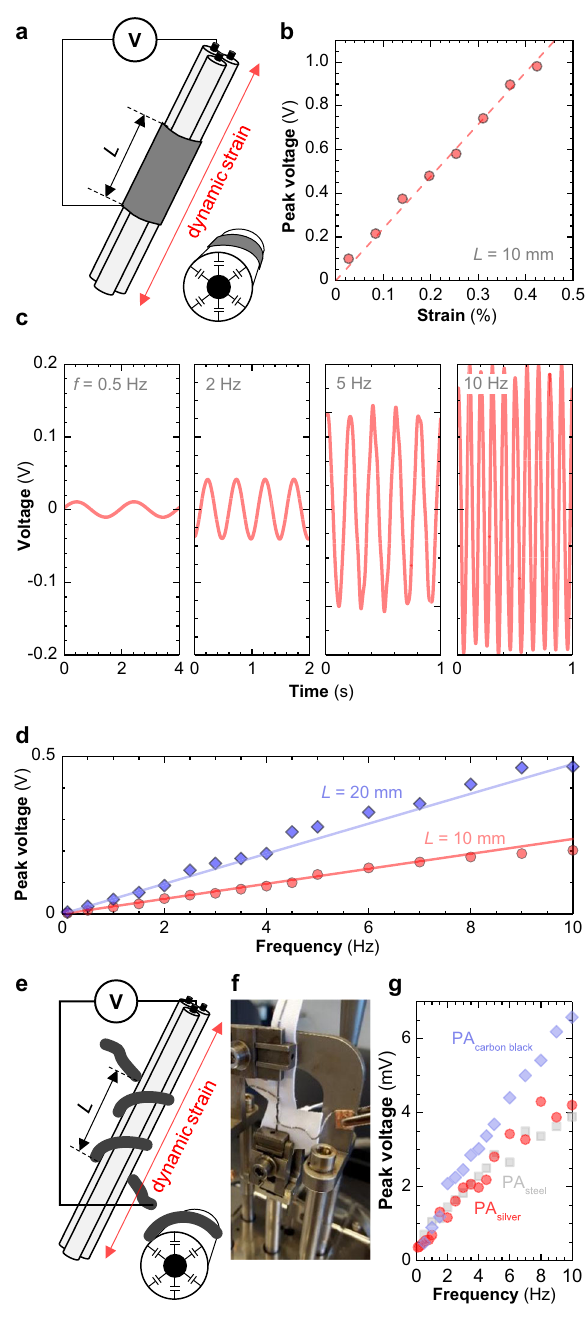
Fig. 2 Piezoelectric characterisation of single piezoyarns. a Sche- matic of a piezoyarn with silver paste applied over a length L . For clarity, only 3 fi laments are depicted instead of all 24. b Piezoelectric output at a dynamic strain frequency of f = 10 Hz as a function of peak dynamic strain ε ( L = 10 mm). c Sinusoidal piezoelectric voltage for f = 0.5, 2, 5 and 10 Hz ( ε = 0.1%). d Measured (symbols) and calculated (solid lines) piezoelectric peak voltage as a function of frequency for L = 10 mm (red circles) and 20 mm (blue diamonds). e Schematic illustration of a piezoyarn with a conducting yarn as the outer electrode. For clarity, only 3 bicomponent fi laments are depicted instead of all 24. f A piezoyarn with a PA silver conducting yarn as the outer electrode mounted in a dynamic mechanical analysis (DMA) instrument. g Generated peak voltage as a function of frequency for the piezoyarn with a conducting yarn as the outer electrode: PA carbon black (blue diamonds), PA steel (grey squares), and PA silver (red